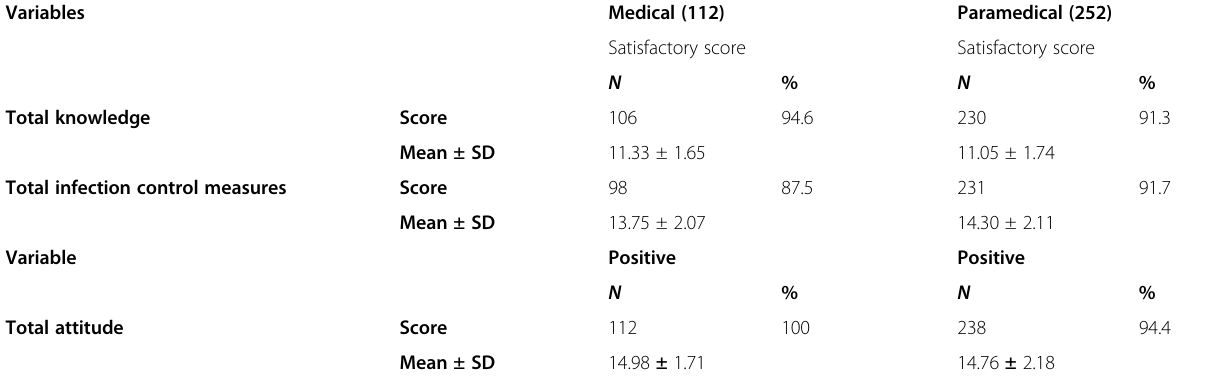
Table 2 Level of knowledge, infection control measures, and attitude score of the studied staff (medical and paramedical) regarding COVID-19 ( n = 364)